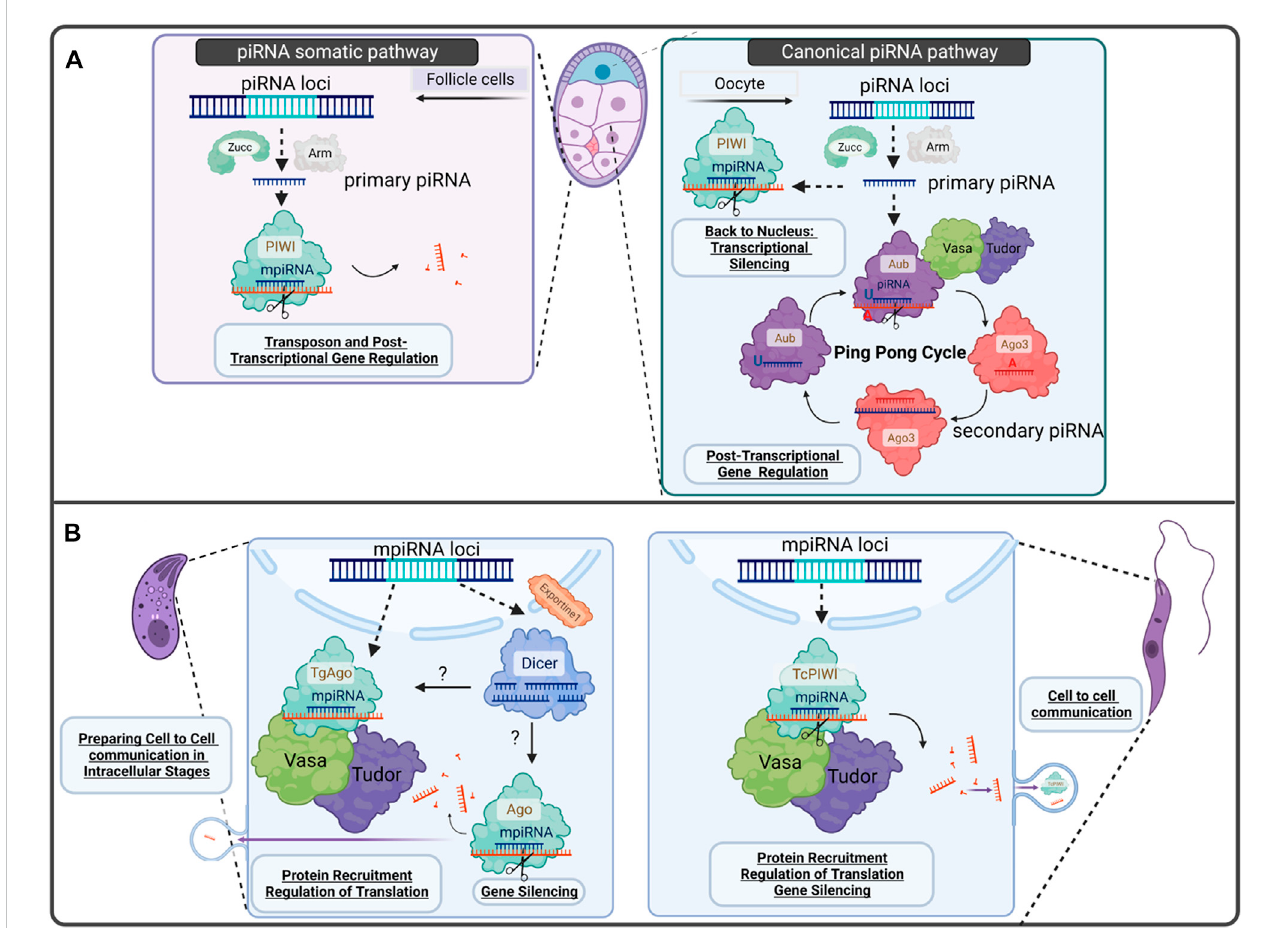
FIGURE 2 Gonadal-piRNApathway vs. proposedmodelforProtozoaparasites-relatedpiRNApathwaysdiscussedinthisperspective . (A) CanonicalpiRNApathway found in D. melanogaster egg chamber . On the left, we can observe the somatic piRNAs at follicle cells where transcribed piRNA cluster by RNA Pol II RNA polymerase are processed in primary piRNAs, binds to PIWI proteins and are guided to silence TE invaders or target mRNAs for post-transcriptional gene regulation. On the right, the canonical piRNA pathway in germline cells from the ovary of D. melanogaster is shown. Primary piRNA biogenesis occurs in folliclecellsatthe nuage .There,thereisapiRNAampli fi cationprocesscalled ping-pongcycle. ThepiRNAsproducedduringthisprocessarecalled secondary piRNAs ). Primary piRNAs can also bind to PIWI protein and go back to the nucleus to remodel chromatin, for example, and regulate gene transcription. (B) ProposedmodelforApicomplexaandTrypanosomatidsPIWI-likeproteinsdiscussedinthisperspective. T.gondii expressesTgAgo,Vasa,TudorandDicer.We proposed an intermediate mechanism between RNAi and piRNA biogenesis, where mpiRNAs are transcribed in the nucleus to reach the cytoplasm to fi nd Dicer or Ago/PIWI-like proteins. After being processed, mpiRNAs, they can either be secreted to mediate cell to cell, and cell-host communication or target mRNAs to control gene expression. In T. cruzi , mpiRNAs are composed mainly of tRNA halves recruited by TcPIWI-tryp and in T. gondii TgAgo: srRNAs and